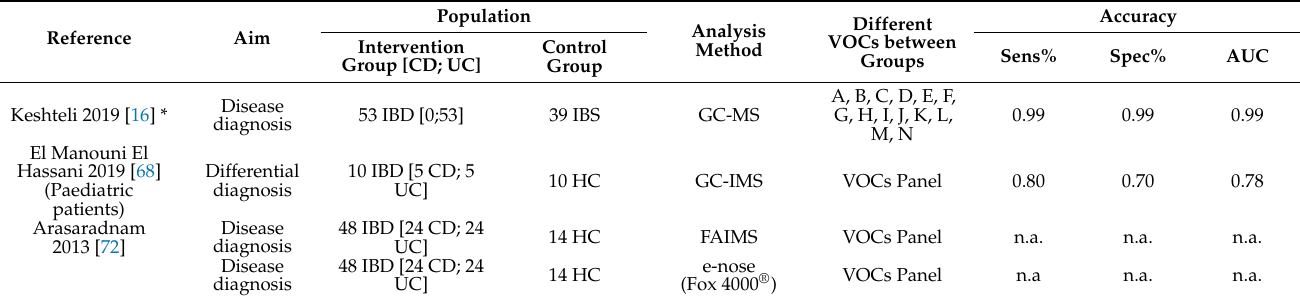
Table 7. Urinary VOCs and IBD diagnosis and activity